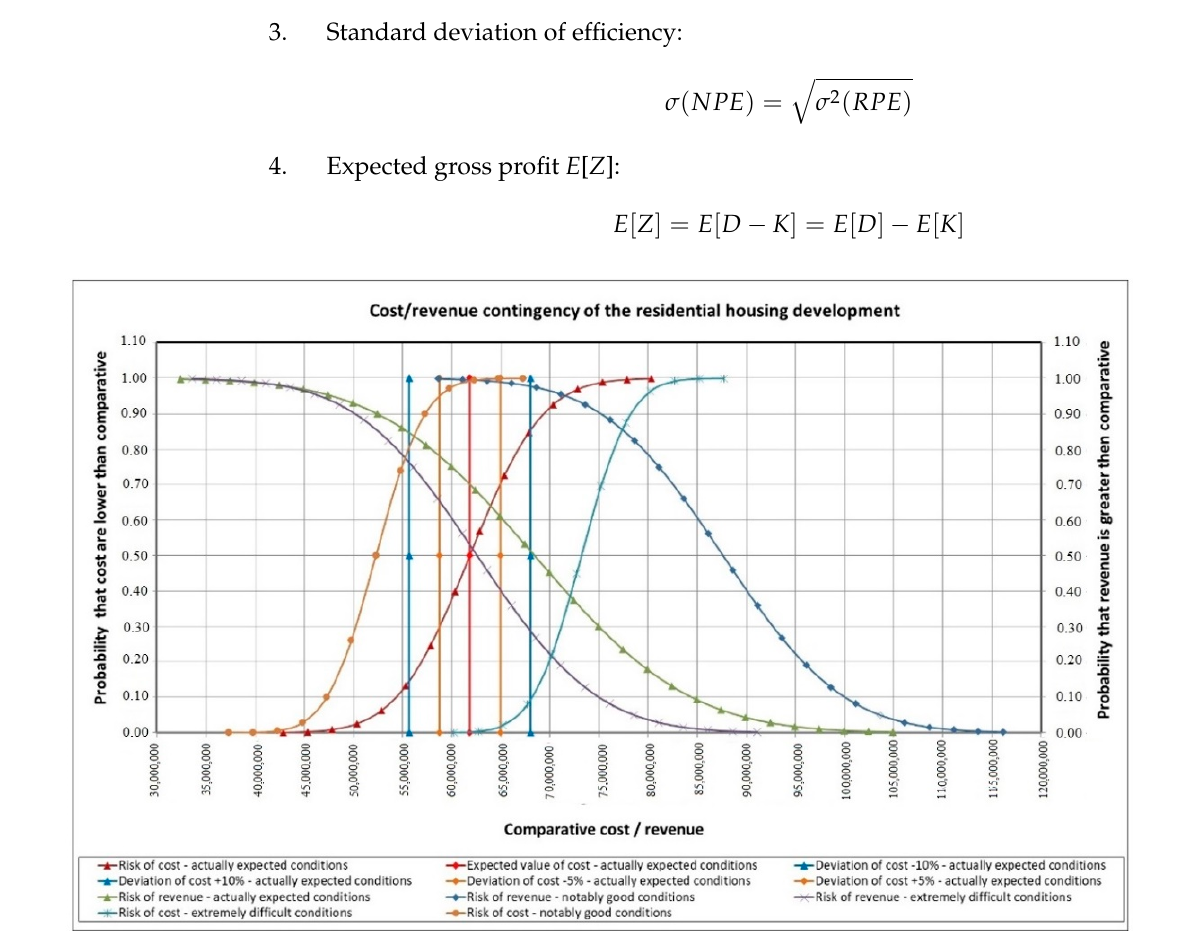
Figure 1. Comparative risk characterization of the costs and revenues of the residential housing development